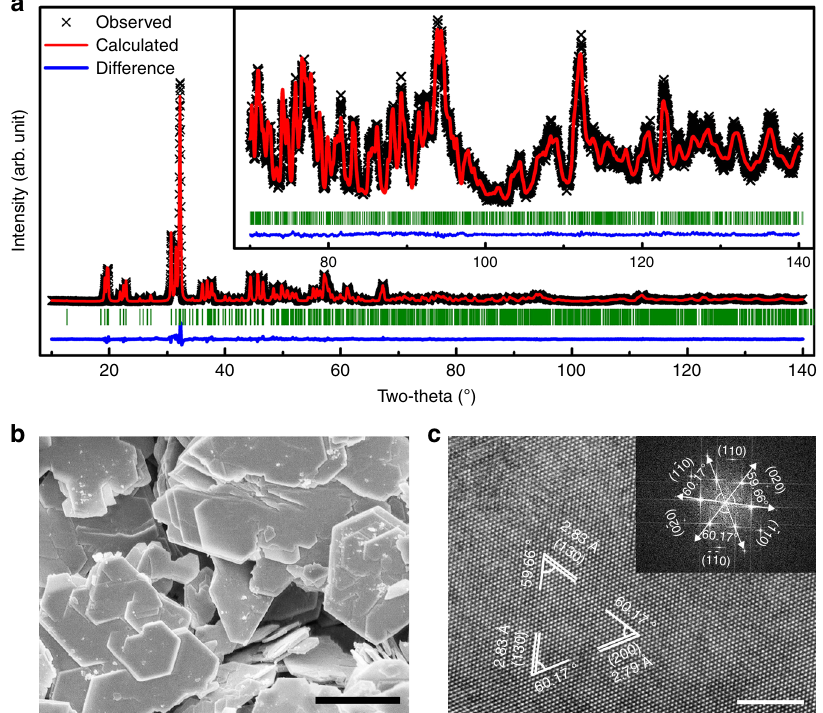
Fig. 2 Structural characterizations of 6H-SrIrO 3 . a , XRD pattern with a re fi nement plot of 6H-SrIrO 3 . b , SEM image of 6H-SrIrO 3 . Scale bar, 2 µ m. c , HRTEM image of 6H-SrIrO 3 . Scale bar, 5 nm. Inset: the corresponding fast Fourier transform